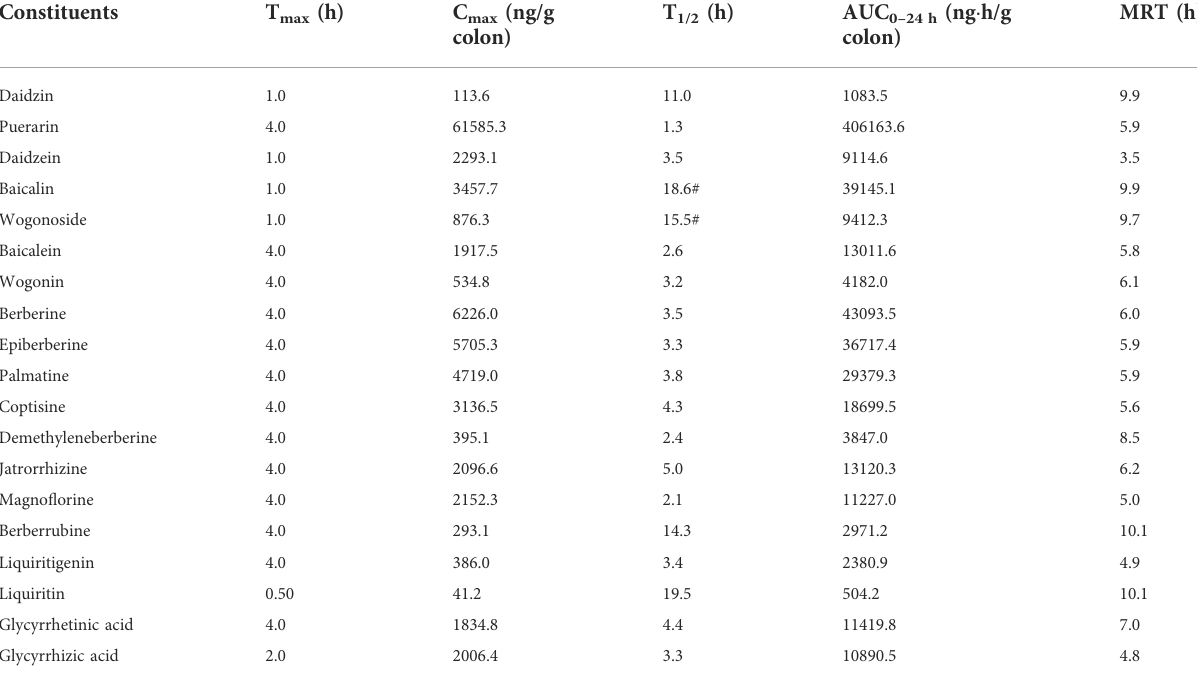
TABLE 6 Pharmacokinetic parameters of the constituents in the colons of the mice received the oral Gegen - Qinlian decoction extract at the dosage of 6.1 g/kg (mean ± SD, n = 6). Constituents